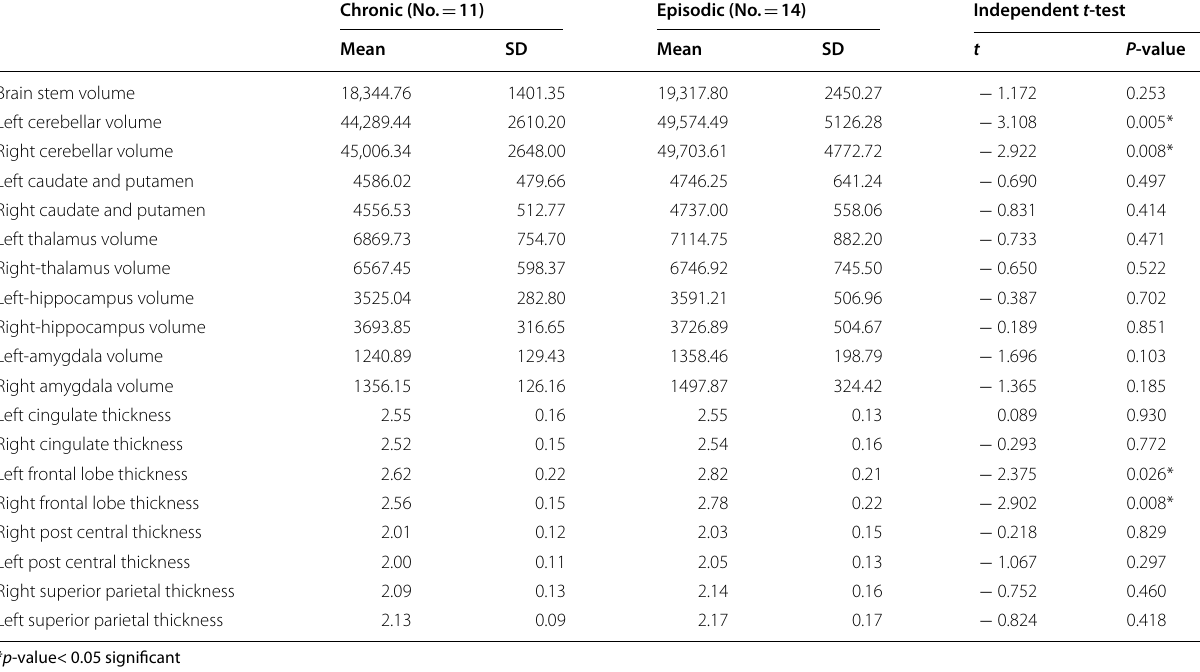
Table 5 Comparison between chronic and episodic migraine patients as regards segmental brain volumetry (mm 3 ) and thickness (mm) parameters